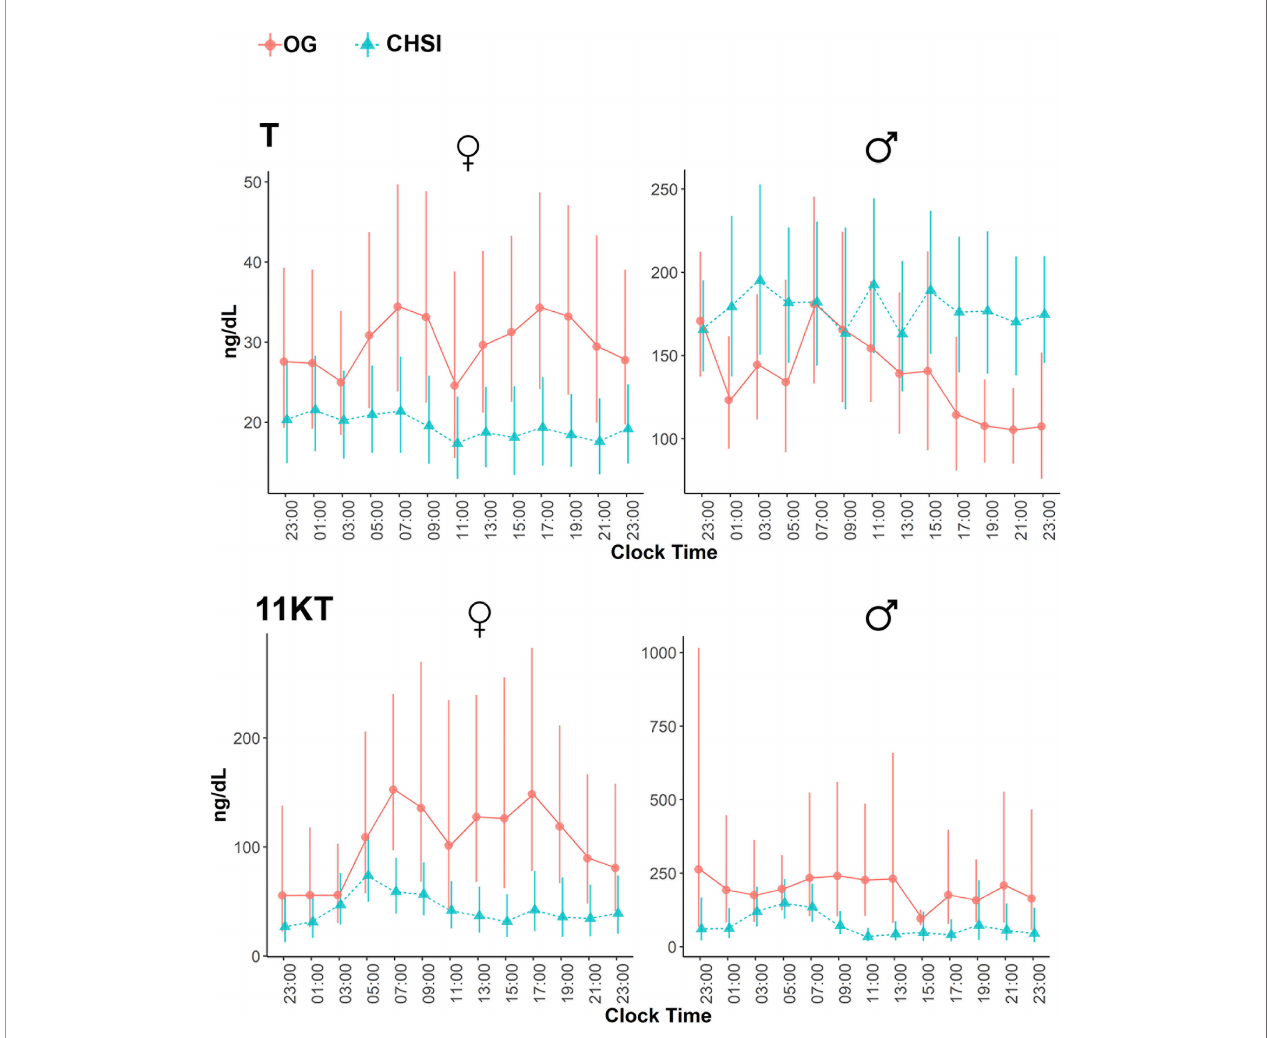
FIGURE 2 | Serum concentrations of testosterone (T) and 11-ketotestosterone (11KT) during conventional oral glucocorticoid therapy (OG, circles), and into 6 months of continuous subcutaneous hydrocortisone infusion (CSHI, triangles), in women (N=5) and men (N=3). Central data represent the geometrical means, and the vertical lines represent the standard errors of the geometrical